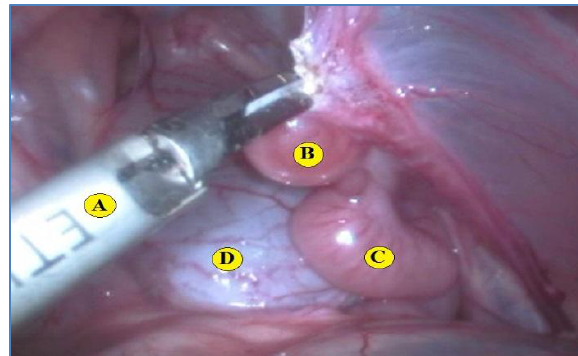
Figure, 1: Laparoscopic view shows the hemostasis and transection the cranial aspect of mesovarium by the harmonic scalpel for ovariectomy. The harmonic scalpel (A), right ovary (B), right uterine horn (C), urinary bladder